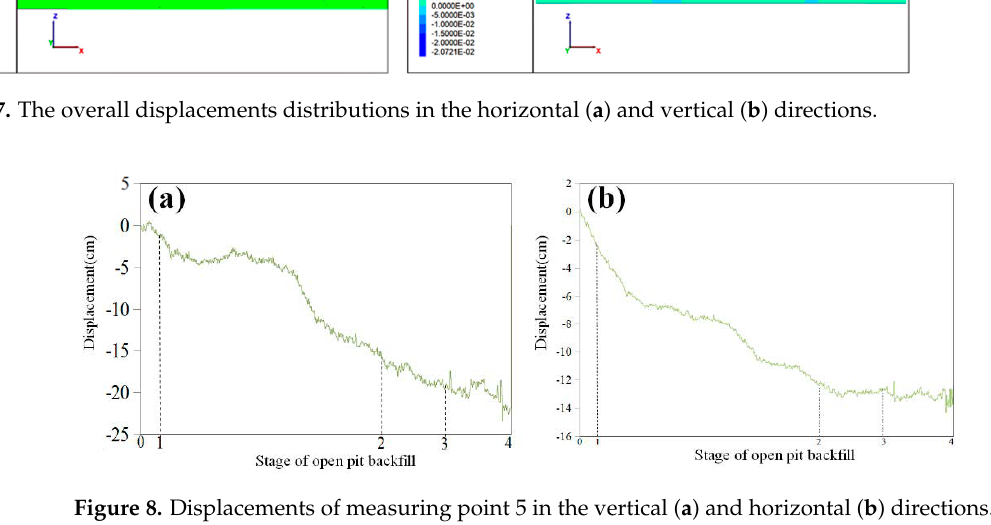
Figure 8. Displacements of measuring point 5 in the vertical ( a ) and horizontal ( b ) directions.